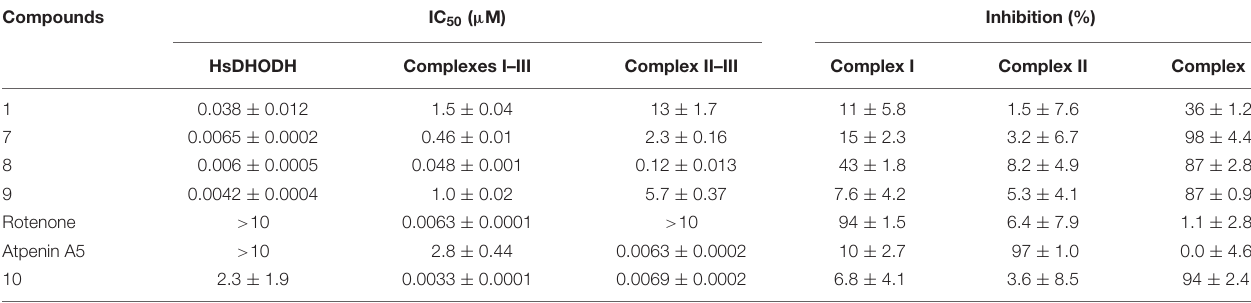
TABLE 6 | IC 50 values of 1 and its derivatives on recombinant human DHODH and bovine complexes I–III, II–III, I, II, and III activities. Compounds IC 50 ( µ